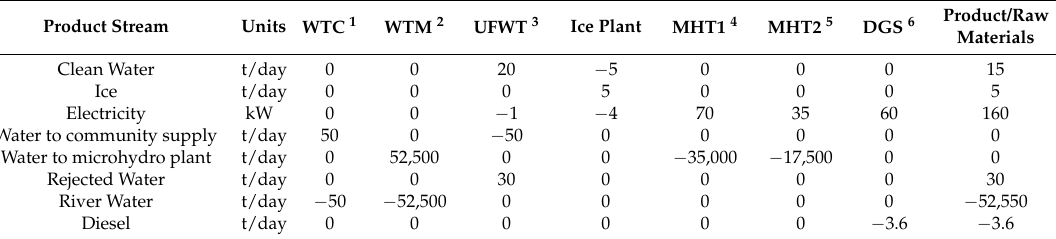
Table 5. The balanced process matrix of case study 3.